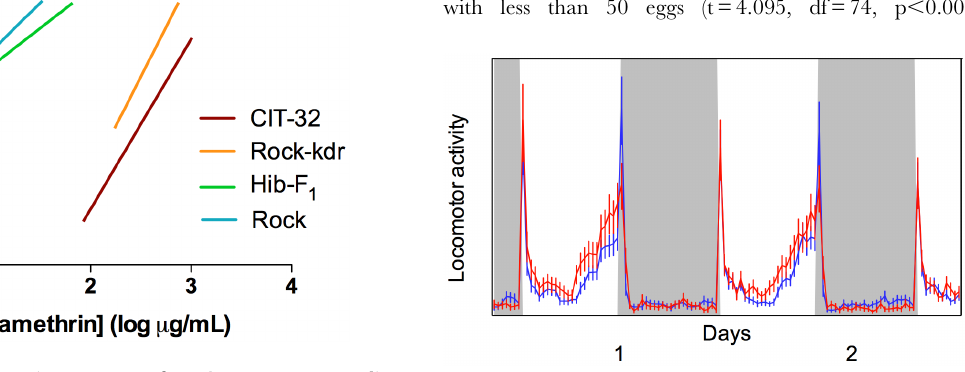
Figure 4. Locomotor activity Rock and Rock-kdr Ae. aegypti strains. Locomotor activity of susceptible (Rockefeller strain – blue line) and pyrethroid resistant (Rock-kdr – red line) Aedes aegypti females exposed two days under LD 12:12, at 25 u C. Dotted lines represent standard errors.